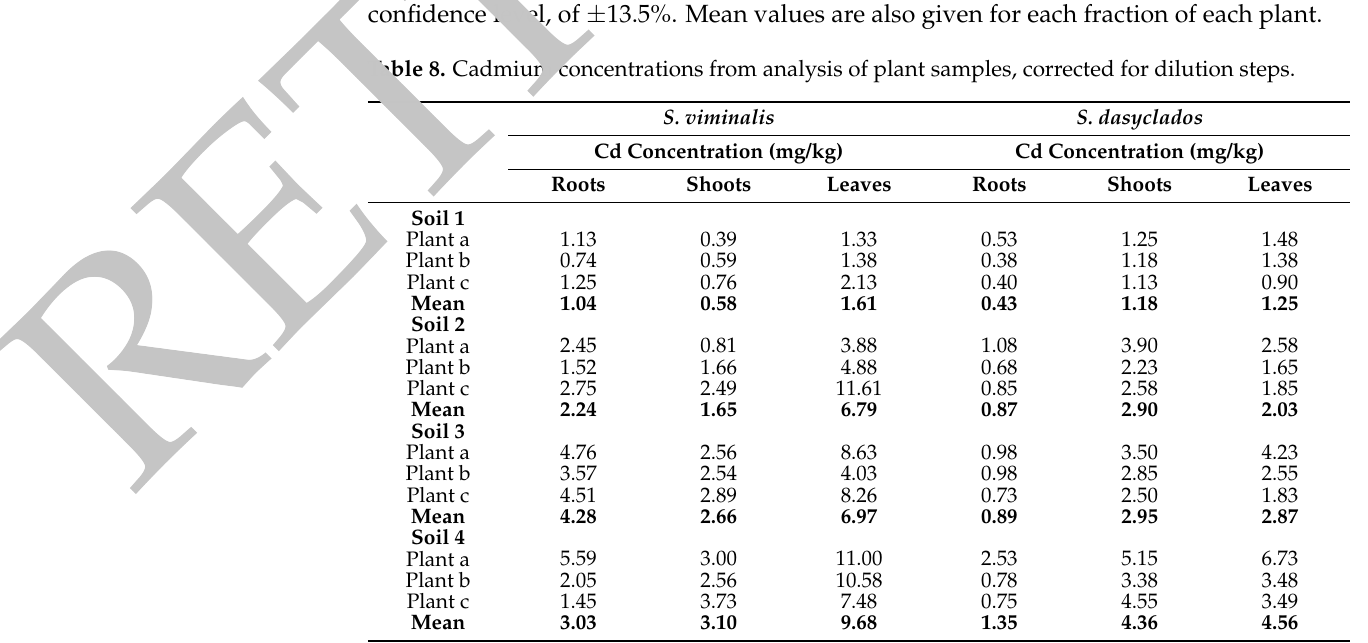
Table 8. Cadmium concentrations from analysis of plant samples, corrected for dilution